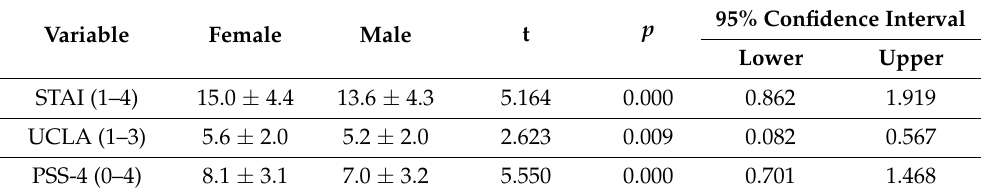
Table 2. Differences between gender of the psychological profile of